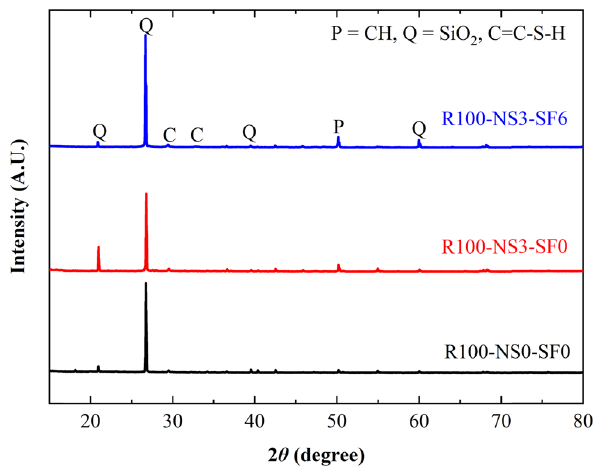
Figure 19: XRD patterns of RAC, SSRAC, and